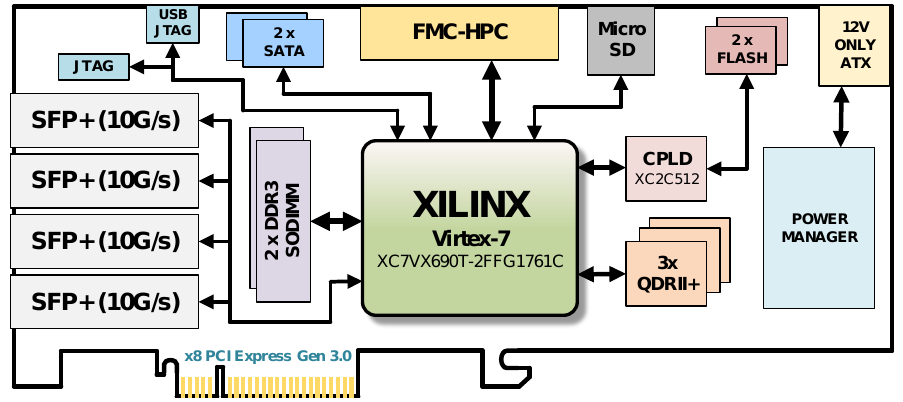
Figure 7. High level block diagram of the NetFPGA-sume board.